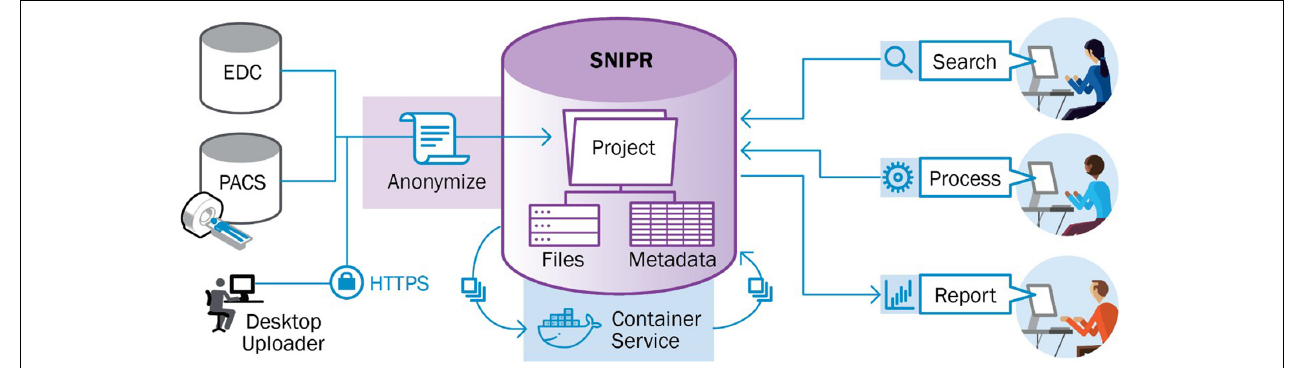
FIGURE 1 | Imaging data can be extracted from picture archiving and communication system (PACS) using DICOM interfaces implemented in XNAT. Alternatively, users can upload DICOM image files using a desktop application. SNIPR automatically removes patient identifying information from DICOM metadata. Clinical attributes can be downloaded from Electronic Data Collection (EDC) systems in spreadsheet format and uploaded into SNIPR via spreadsheets or entered into web-based form. XNAT automatically links the clinical and image data to enable searching and aggregation across domains.